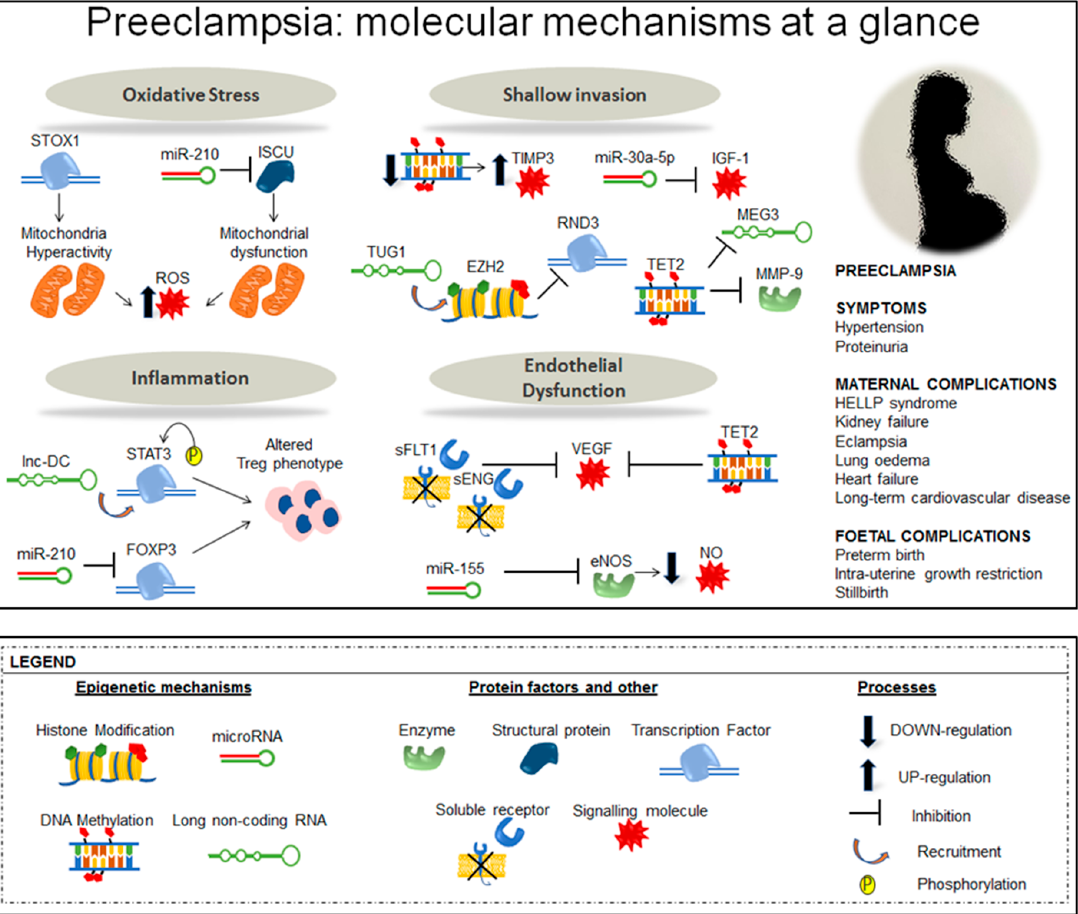
Figure 2. Overview of the molecular mechanisms at play in preeclampsia. Annotations: eNOS = Endothelial Nitric Oxide Synthase; EZH2 = Enhancer of Zeste Homolog 2; FOXP3 = Forkhead box P3; IGF-1 = Insuline-like Growth Factor 1; ISCU = Iron-sulfur cluster; Lnc-DC = Long non-coding RNA DC; miR-30a-5p = microRNA 30a-5p; miR-155 = micro-RNA 155; miR-210 = microRNA 210; MMP-9 = Matrix Metalloproteinase-9; NO = Nitric Oxide; RND3 = Rho Family GTPase 3; ROS = Reactive Oxygen Species; sENG = Soluble endoglin; sFLT1 = Soluble fms-like tyrosine kinase receptor -1; STAT3 = Signal transducer and activator of transcription 3; STOX1 = Storkhead Box 1; TET2 = Tet methylcytosine dioxygenase 2; TIMP3 = TIMP Metallopeptidase Inhibitor 3; TUG1 = long non-coding RNA taurine-upregulated gene 1; VEGF = Vascular Endothelial Growth Factor.